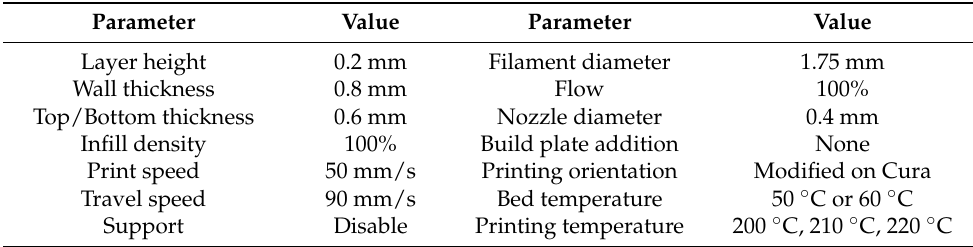
Table 2. Printing conditions considered for PLA and PLA-flax.